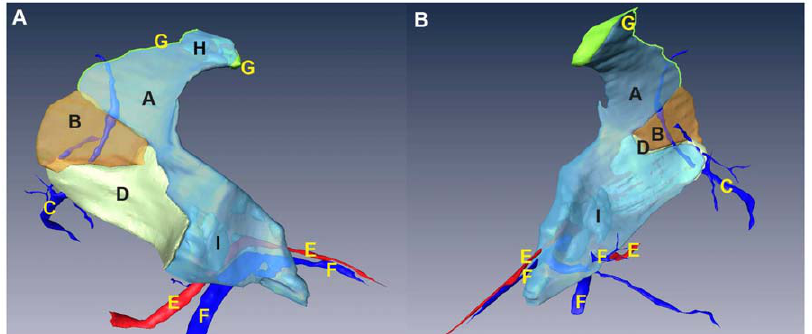
Figure 5. Visualizing the distribution of internal structures of the LES on CVH2 by transparent processing. (A, B) Posterointernal and anteroexternal view of the LES in 3D. The left gastric artery and vein pass through the anteroinferior part of the GBA and enter the lesser omentum. The left gastric lymph nodes are situated behind the left gastric vessels in the GBA, and the left cardiac lymph nodes are situated at the fat pad of the GBA. These structures are located at the corresponding position in the LES. The trunk of the posterior gastric vein passes through the lower segment of the left layer of the gastrophrenic ligament, the GBA, the LSFS, and the GBA, near the posterior border of the LES. Finally, this trunk penetrates through the upper segment of the left layer of the gastrophrenic ligament and enters the posterior wall of the gastric fundus. Similarly, the posterior branch of the posterior gastric vein goes straight through the lower segment of the left layer of the gastrophrenic ligament at its posterior margin and reaches the gastric wall. A: GBA; B: LSFS; C: posterior gastric vein and its branches; D: lower segment of the left layer of the gastrophrenic ligament; E: left gastric artery; F: left gastric vein and its branches; G: upper segment of the left layer of the gastrophrenic ligament; H: left cardiac lymph nodes; I: left gastric lymph nodes.